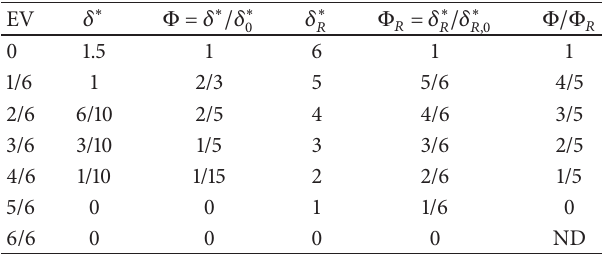
Table 4: Average diffusion coefficients of the submodel